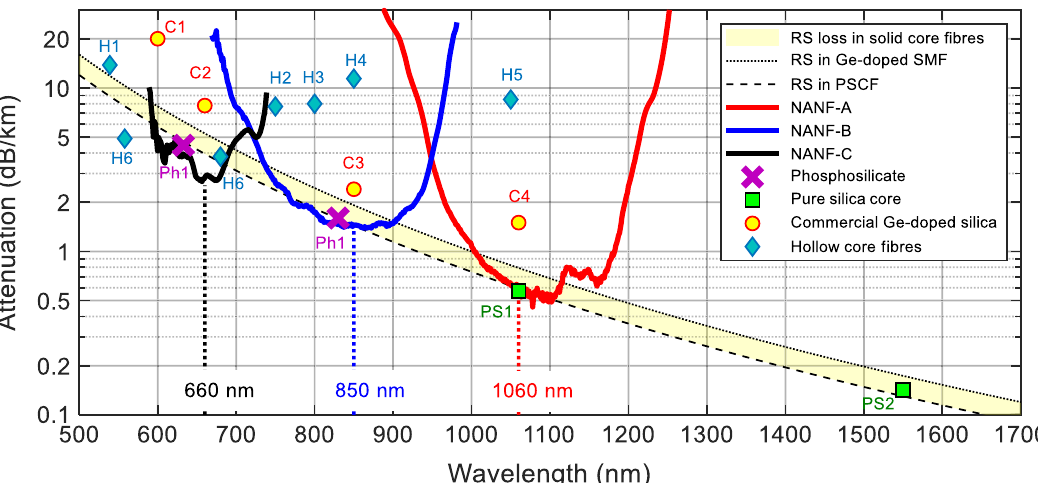
Fig. 3 Loss of NANFs reported in this work. NANF-C operating at 660 nm (solid black), NANF-B operating at 850 nm (solid blue), and NANF-A operating at 1060 nm (solid red). The shaded yellow band represents the fundamental Rayleigh scattering loss of state-of-the-art solid-core fi bres, its lower limit (black dashed line) represents what is achievable with pure silica core technology (PS1 is from Nagayama et al. 9 , while PS2 is from Tamura et al. 7 ). The upper bound of the shaded area (black dotted curve) is compatible with state-of-the-art commercial germanium doped silica fi bres 11 . On a similar low- scattering curve are two multimode phosphosilicate fi bres produced in the 1970s (Ph1, Horiguchi et al. 45 ). The four yellow circular markers indicate the typical loss of commercial solid core fi bres between 600 and 1060 nm (C1: single-mode fi bre at red visible wavelengths 47 ; C2: large-area single-mode photonic crystal fi bre LMA-5 48 ; C3: highly multimode graded-index OM5 fi bre for datacoms 49 ; C4 single mode high numerical aperture fi bre for 980 nm pump delivery 50 ). The blue diamond markers represent the current state-of-the-art loss in hollow-core fi bres - H1: Chafer et al. 51 ; H2: Debord et al. 52 ; H3: Debord et al. 24 ; H4: Chafer et al. 23 ; H5: Maurel et al. 53 ; and H6: Gao et al. 32